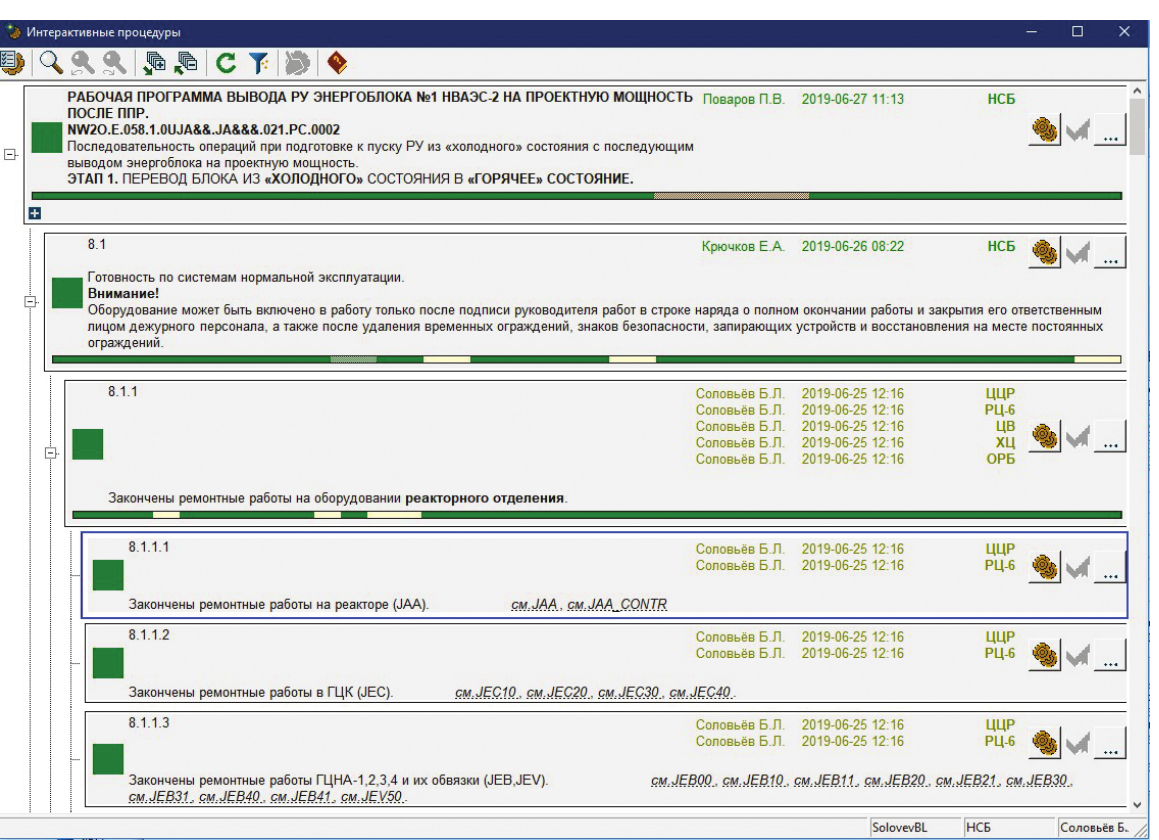
Figure 2. Interactive procedure (typical